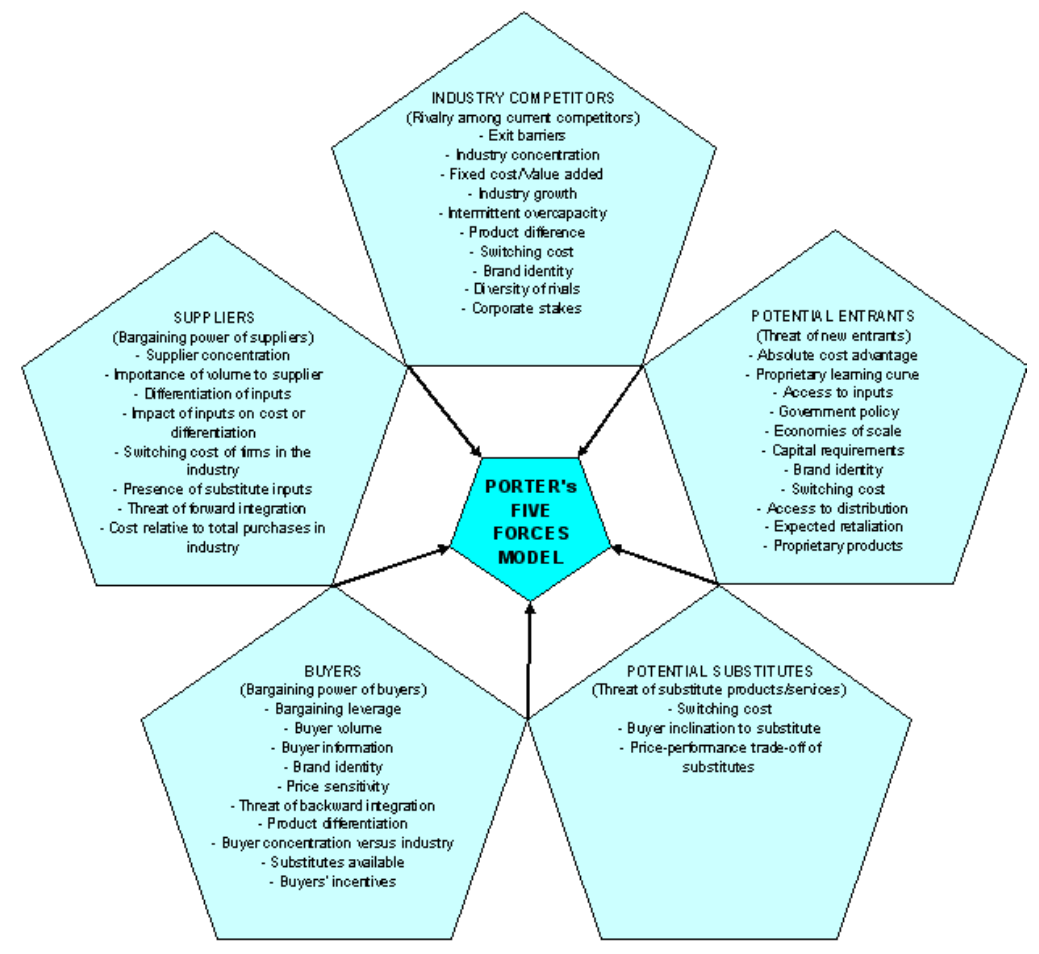
Figure 2 Porter’s five competitive forces model, with industry factors that influence each force